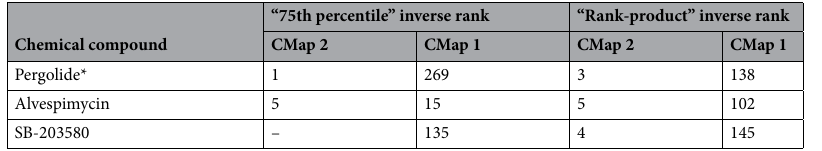
Table 3. Compound rankings from GSEA-analysis using previously reported signatures from Ferguson et al. (2018) that is further summarized using the “75th Percentile” and “Rank-Product” methods as described in the original publication. Inverse-ranks are reported for “reversing” the query signatures. Compounds marked with asterisks (*) were experimentally validated. The CMap 1 ranks are relative to CMap 2 compounds contained in CMap 1.